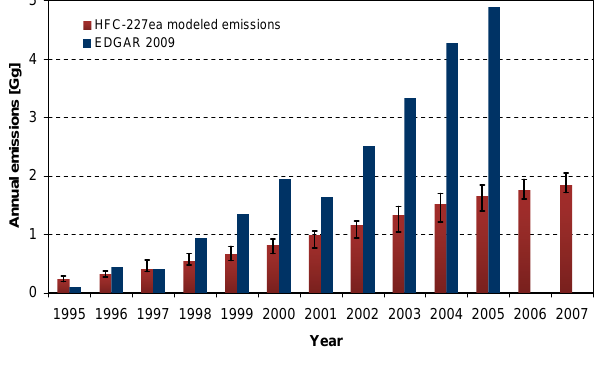
Fig. 2. Emission estimates as derived from trends of HFC-227ea in firn air in comparison with those reported by the EDGAR emission database (EDGAR, 2009). The primary sink for HFC-227ea is re- action with the OH radical in the troposphere. Therefore error bars were calculated as the root of mean of the squares of the summed uncertainty in the OH concentration and in the respective reaction rate coefficient as well as firn air related uncertainties (correspond- ing to the minimum and maximum scenarios in Fig.